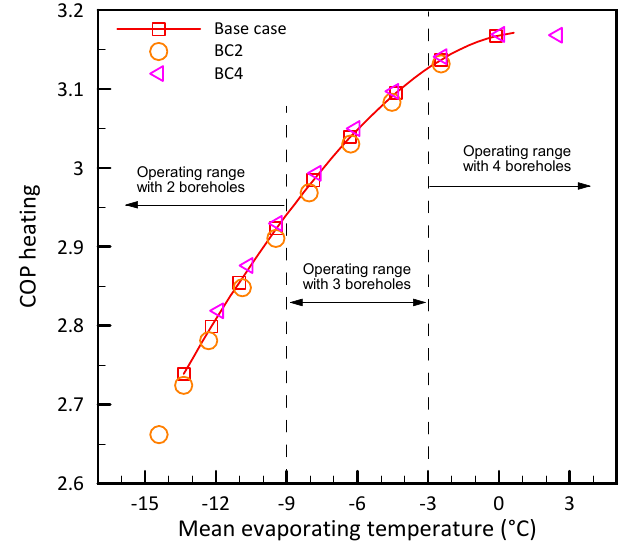
Figure 12. Coefficient of performance ( COP heating ).